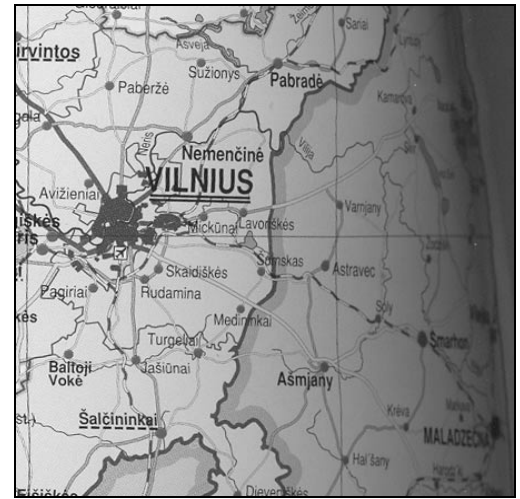
3 pav. Geometrin ė s deformacijos Fig 3. Geometric